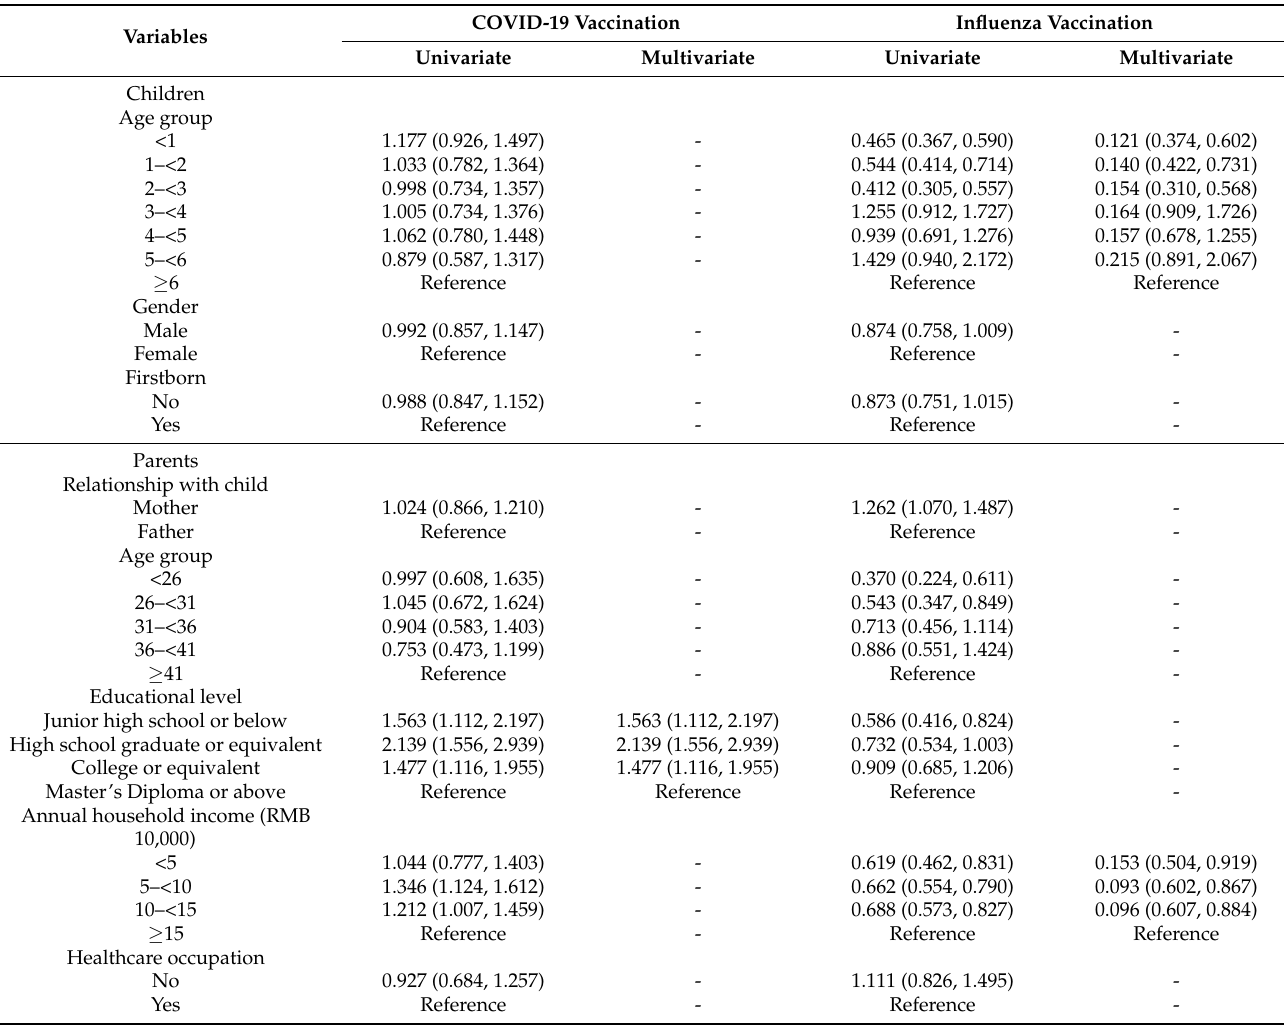
Table 4. Univariate and multivariate factors of parental COVID-19 and influenza vaccination acceptance, OR (95% CI) *. COVID-19 Vaccination Influenza Vaccination Variables Univariate Multivariate Univariate Multivariate Children Age